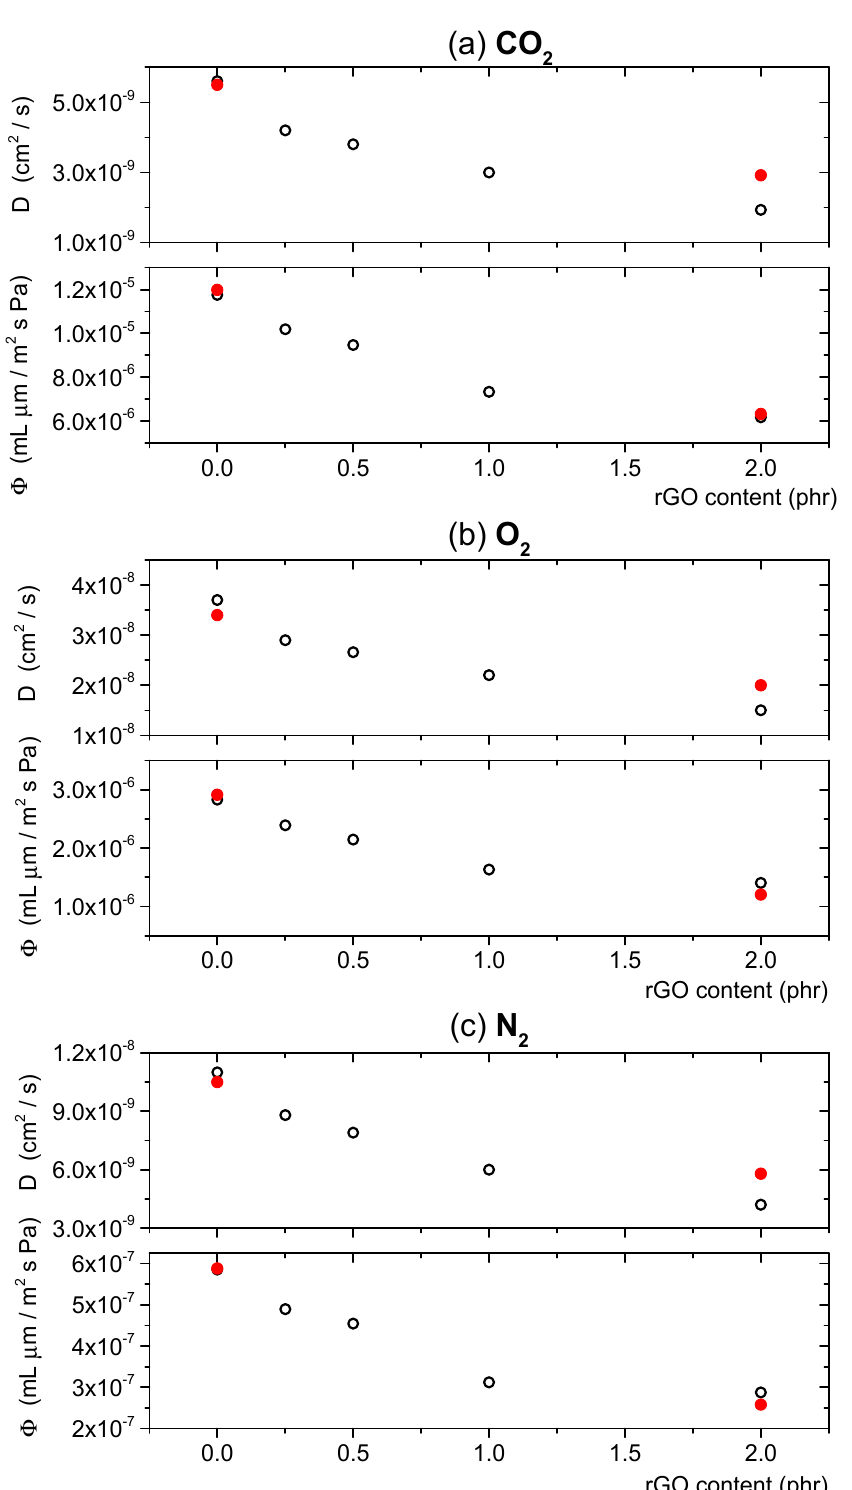
Figure 10. Diffusivity ( D ) and permeability ( Φ ) values pertinent to CO 2 ( a ), O 2 ( b ) and N 2 ( c ) as a function of the rGO content for the samples PLA-rGOx (solid symbols) and PLA-PDoF-rGOx (open symbols) (x = 0.25 ÷ 2 phr). Experimental indeterminations are inside the size of the symbols. The lateral size L of the present rGO nanoparticles is ~500 nm, as discussed for SEM results (Figure 1). Assuming a thickness W ~ 1 nm [51], then α = L / W ∼ 500.